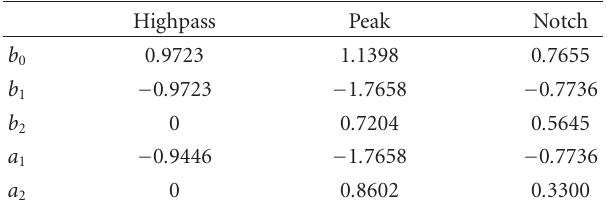
Table 1: Filter coe ffi